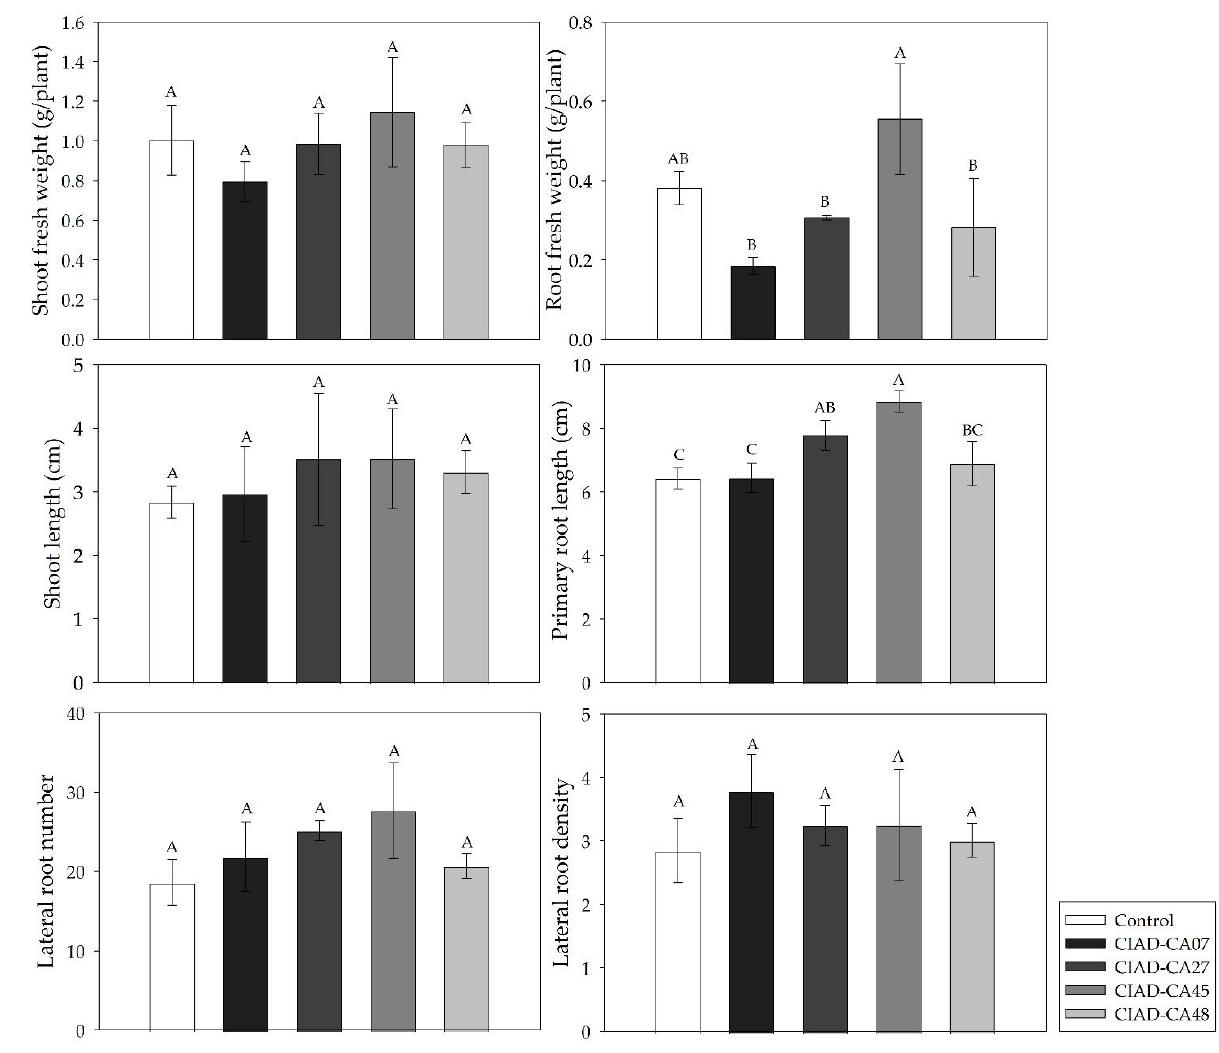
Figure 4. Effect of VOCs emitted by Streptomyces strains on biomass production in P. vulgaris seedlings. Mean values with the same letters are statistically similar. Thin upper bars indicate the standard deviations of the means.